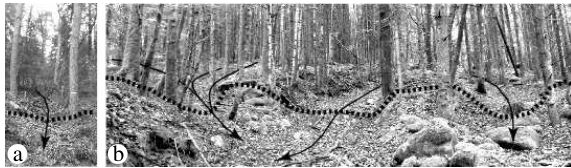
Figure 12. Comparative views of: a) shallow structures on steep slope; b) intricated deep